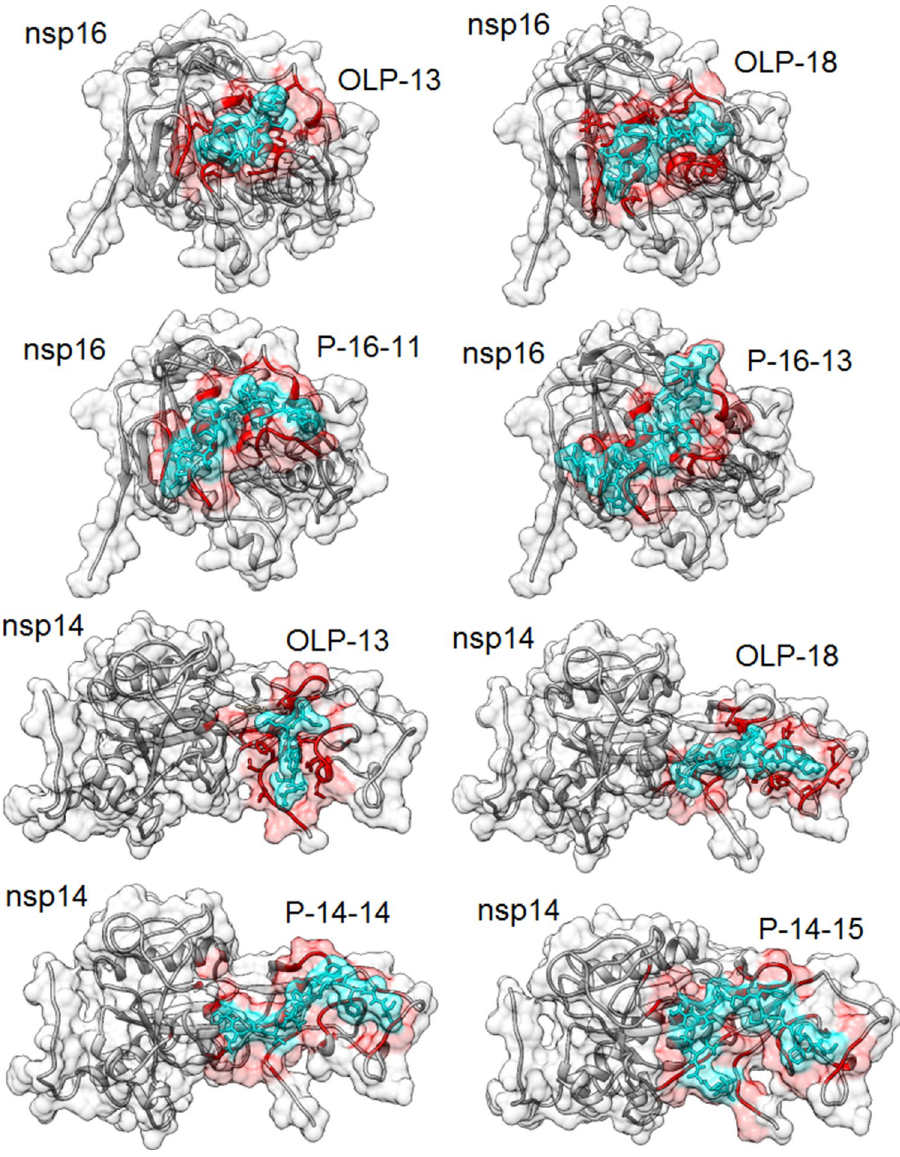
Figure 5. 3D structure representations of the best scoring designed peptides to the target proteins (nsp16 and nsp14). The key interacting residues and peptides are colored in red and turquoise, respectively.